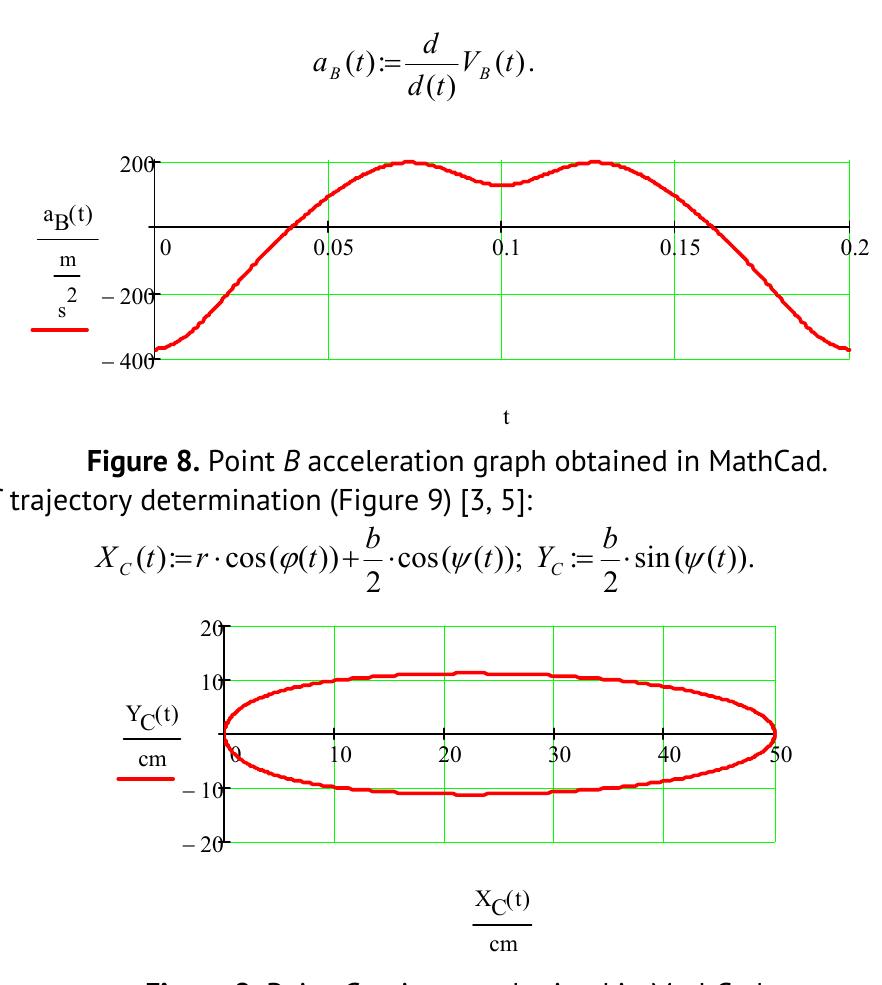
Figure 9. Point C trajectory obtained in